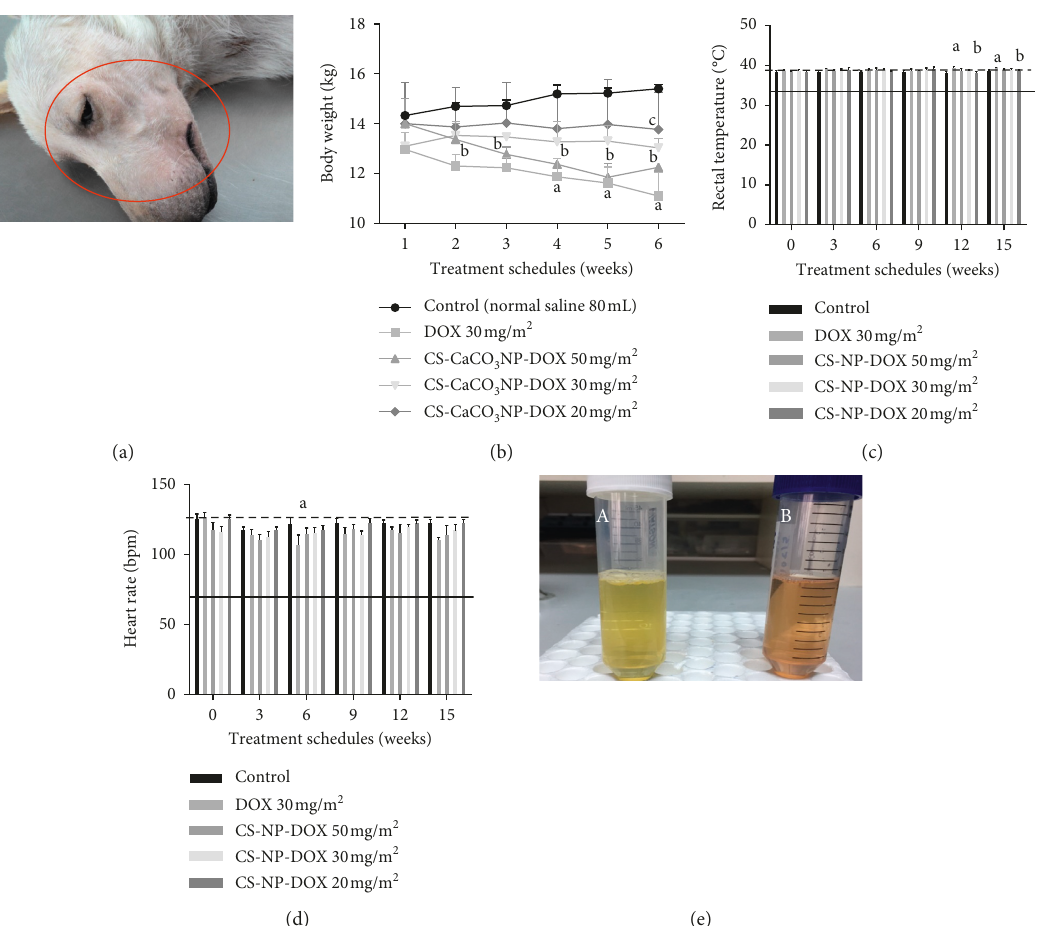
Figure 1: Effect on physical and clinical parameters. (a) Dermal lesion on the facial region of the dogs given free DOX after the 4th cycle. (b) Effect of treatment groups from onset to 3 weeks after the 5th cycle on the body weight (kg). (c) Effect of treatment groups from onset to 3 weeks after the 5th cycle on rectal temperature ( ° C). (d) Effect of treatment groups from onset to 3 weeks after the 5th cycle on heart rate (bpm). Values are expressed as mean standard deviation. Different alphabets indicate statistical significance ( p 0 . 05) between groups at different cumulative doses with a, b, c, and d representing significant difference with control, DOX 30 mg/m 2 , CS-CaCO 3 NP-DOX 50mg/m 2 , CS-CaCO 3 NP-DOX 30mg/m 2 , and CS-CaCO 3 NP-DOX 20mg/m 2 , respectively. (e) Urine colour change in dogs given free DOX ± < and CS-CaCO 3 NP-DOX at different